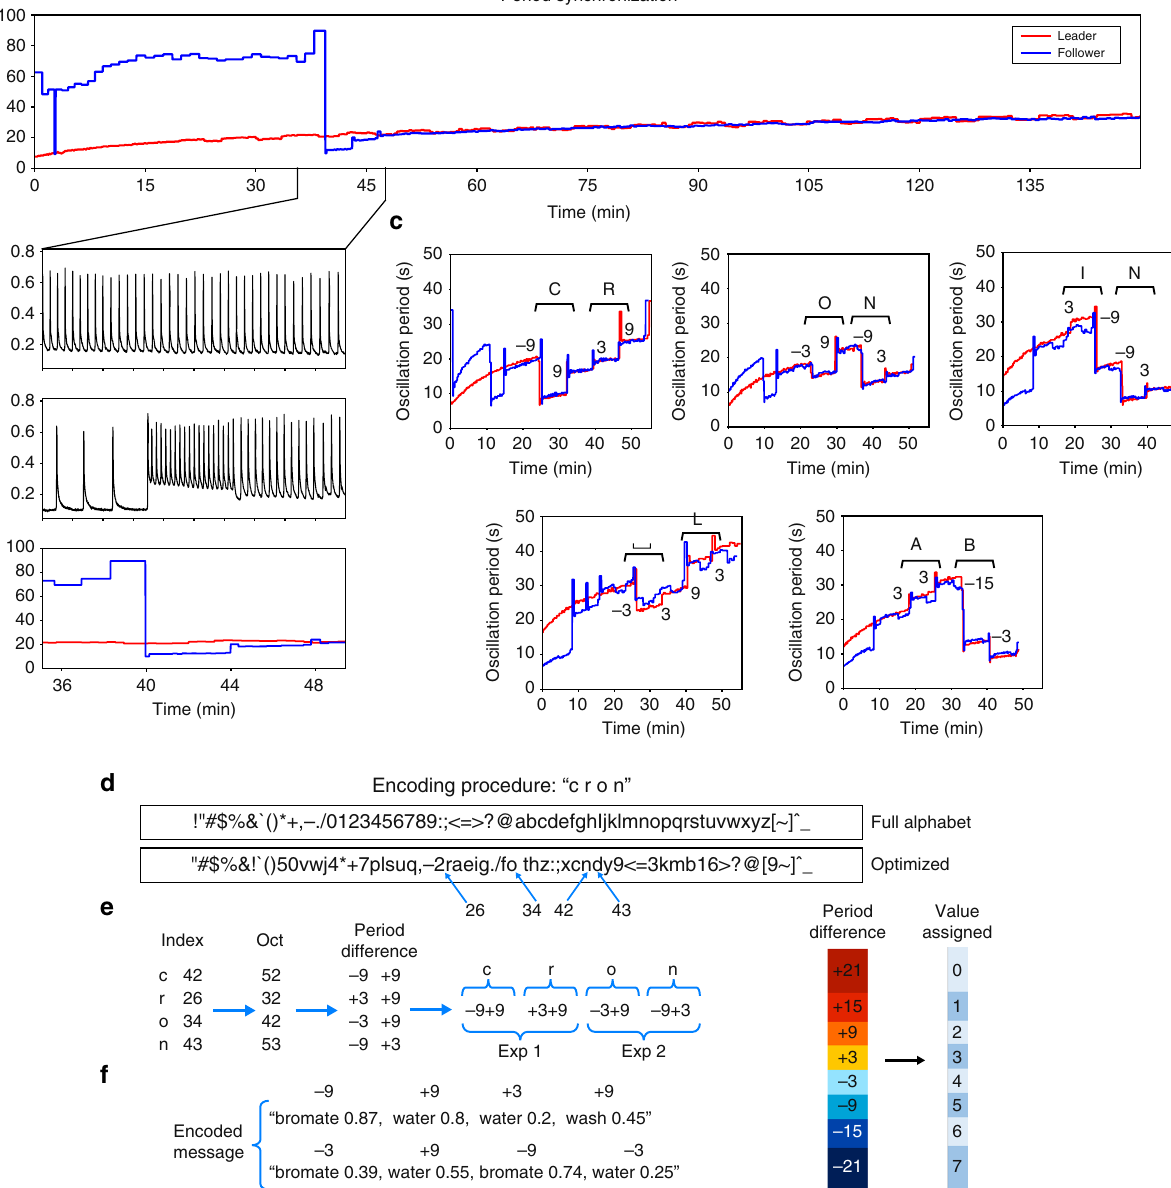
Fig. 5 Real-time control of chemical oscillator. a BZ reaction synchronisation achieved by two units acting as leader and follower. b Zoomed plot of the periods, at 40 min the follower adds potassium bromates and overshoots, the period is then corrected with two small additions of water and is synchronised at 48 min. c Real data of encoding/decoding of ‘ cronin lab ’ . Encoding of the word ‘ cron ’ . d Each character is converted into the relative number using the optimised alphabet. e These numbers are converted fi rst into octal and then into a frequency change by using the threshold table. f Final encoded message, each character is represented by two reagent additions. The amounts are reported as an example since real amounts are dynamic and are calculated in real time by monitoring the oscillation